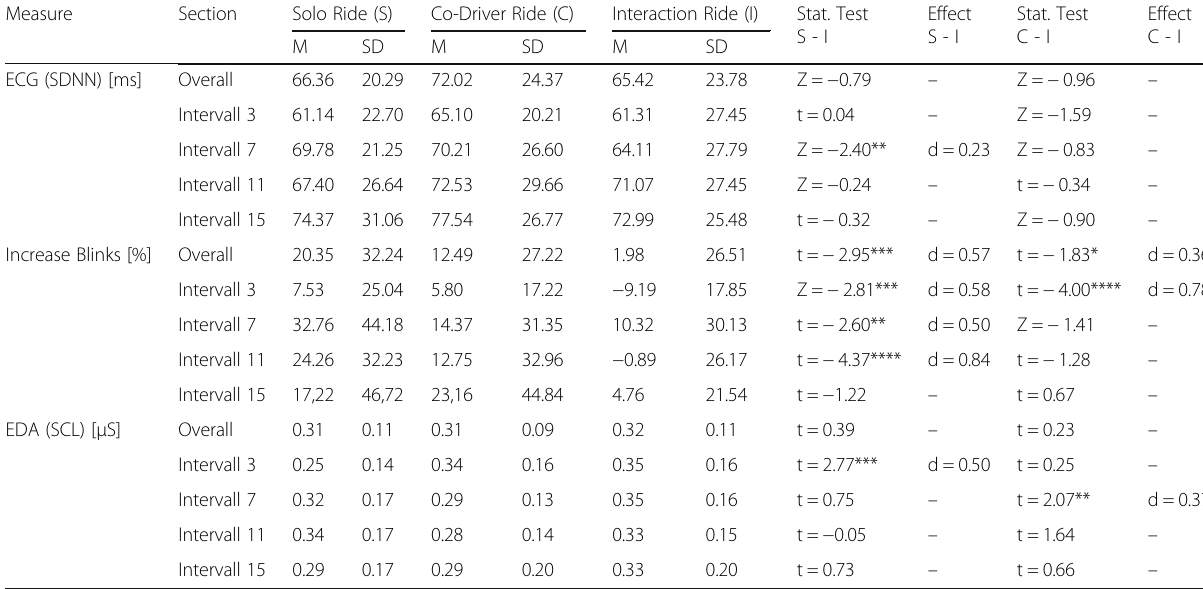
Table 4 Results related to psycho-physiological arousal